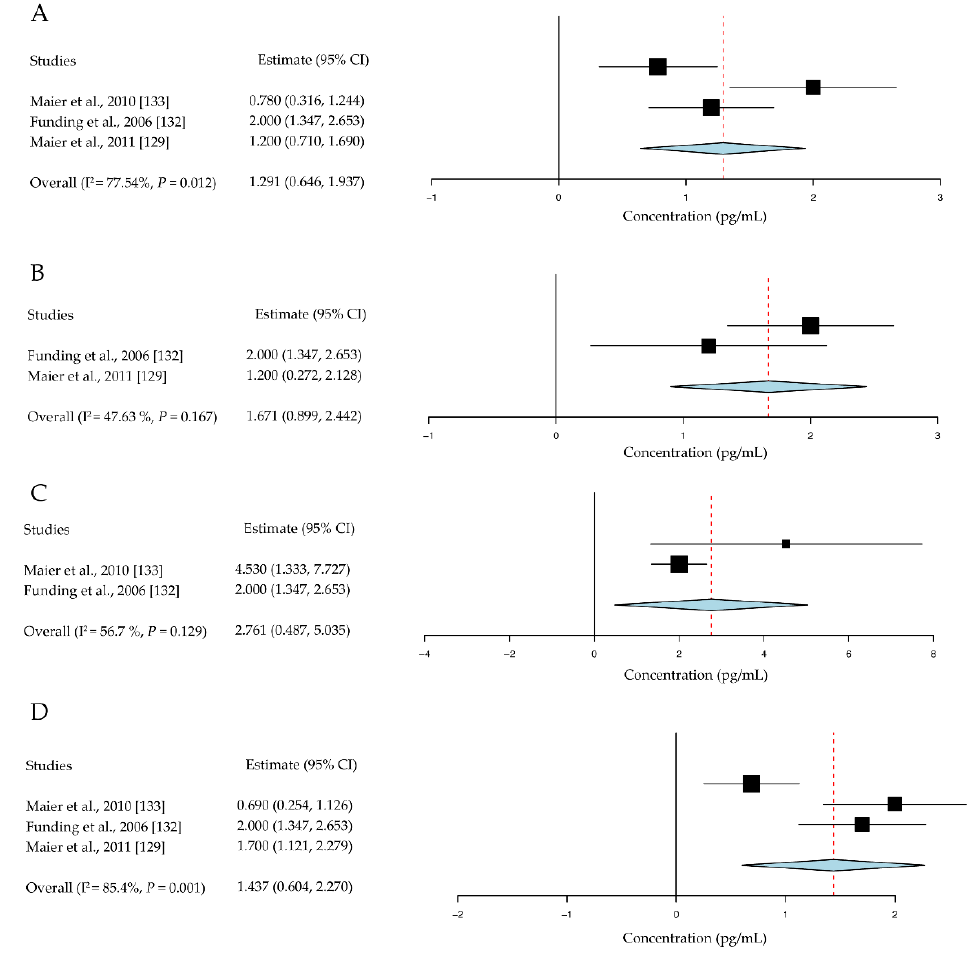
Figure 6. Inflammatory cytokine level in the aqueous humor of human corneal graft cases. ( A ) In the survival group, the level of TNF- α was 1.29 pg/mL (95% CI, 0.65 to 1.94 pg/mL). ( B ) IFN- γ was 1.67 pg/mL (95% CI, 0.90 to 2.44 pg/mL), ( C ) IL-1 β was 2.76 pg/mL (95% CI, 0.49 to 5.03 pg/mL), and ( D ) IL-2 was 1.44 pg/mL (95% CI, 0.60 to 2.27 pg/mL). CI, confidence intervals.